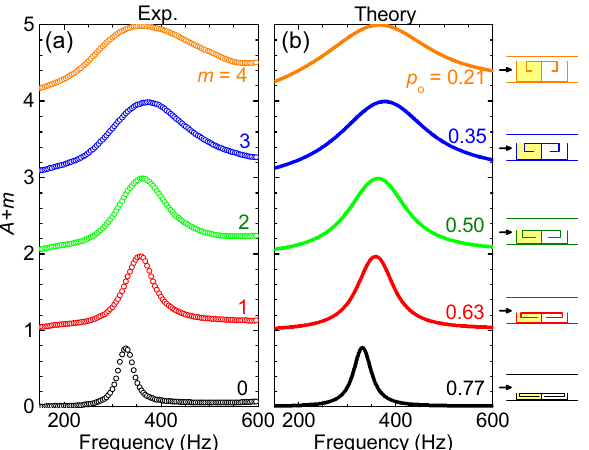
Figure 6. Absorption of 3D printed acoustic bilayer metasurfaces with spacing d = 0 and different open area ratios p o . The left curled channel in the unit cell contains an appropriate amount of porous media, and the right curled channel is hollow. Other parameters are the same as those in Fig. 3. ( a ) Measured and ( b ) simulated absorption spectra. Sound waves are incident from the left.